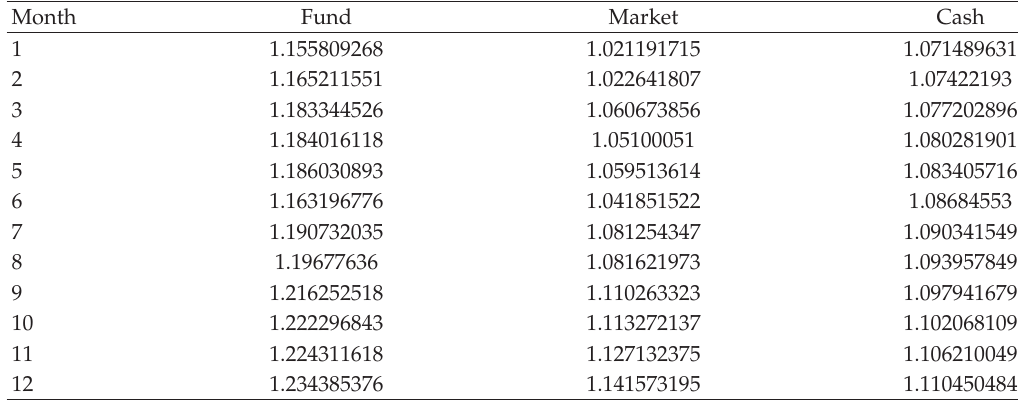
Table 1: Monthly return prices.